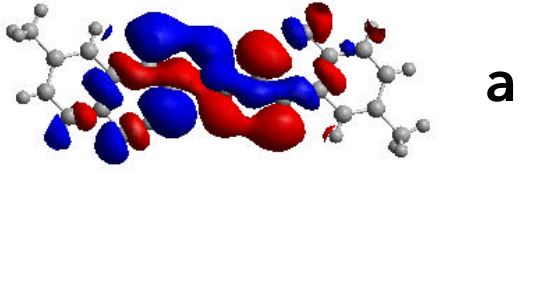
= 24100 cm -1 ) (b) exc